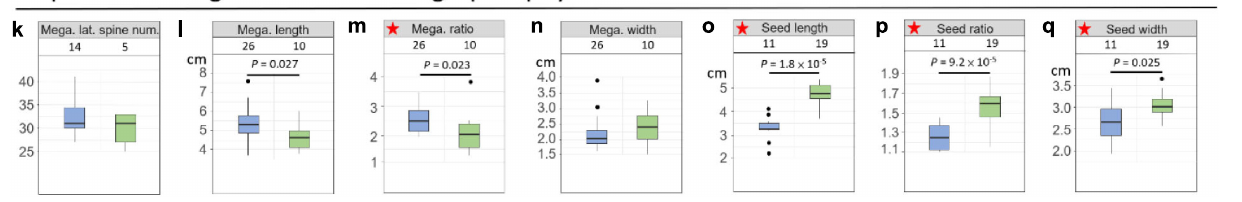
FIGURE 4 | Morphometrics of leaf, leaflet, seed, and megasporophyll. The number block is the sample size. The ratio is calculated as the length divided by the width. The black and red stars are not significant and significant, respectively, diagnostic traits between Cycas revoluta and Cycas taitungensis . The draft of the measured organ is modified from Li and Keng (1975). Insert. angle, insertion angle; Leaflet num. per side, leaflet number per side; Mega. lateral spine num., megasporophyll lateral spine number; Mega. length, megasporophyll lamina length; Mega. ratio, megasporophyll lamina ratio; Mega. width, megasporophyll lamina width. The part labels a–q are the plant trait corresponding to depiction and Table 2 .